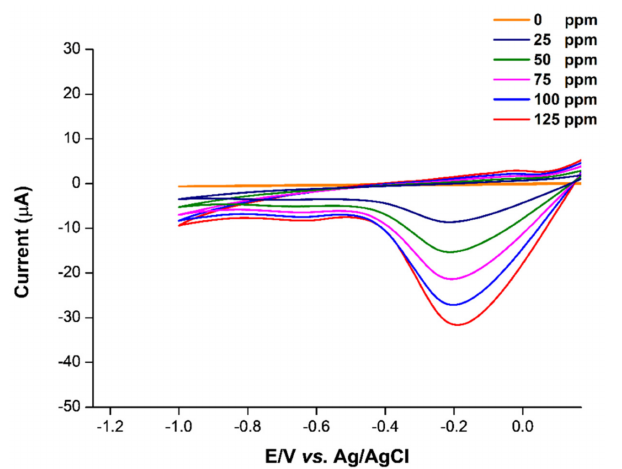
Figure 2. Voltammogram of the single plasticizer sensor. Peak current of the sensor is represented at the potential of − 0.18